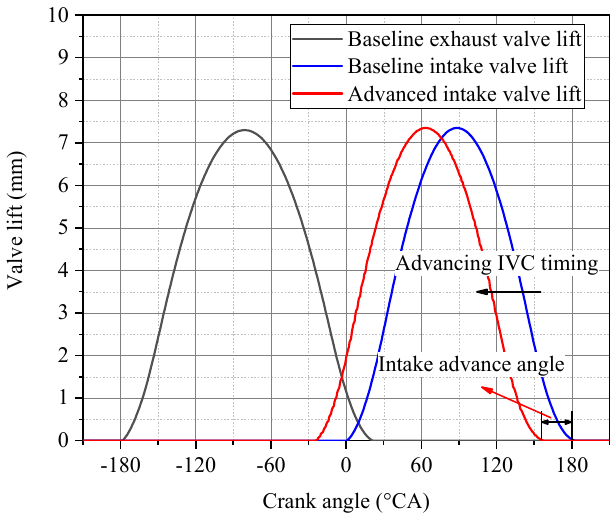
Figure 2. Valve lifts and realization of the Miller cycle (by advancing IVC (Intake Valve Closing) timing).